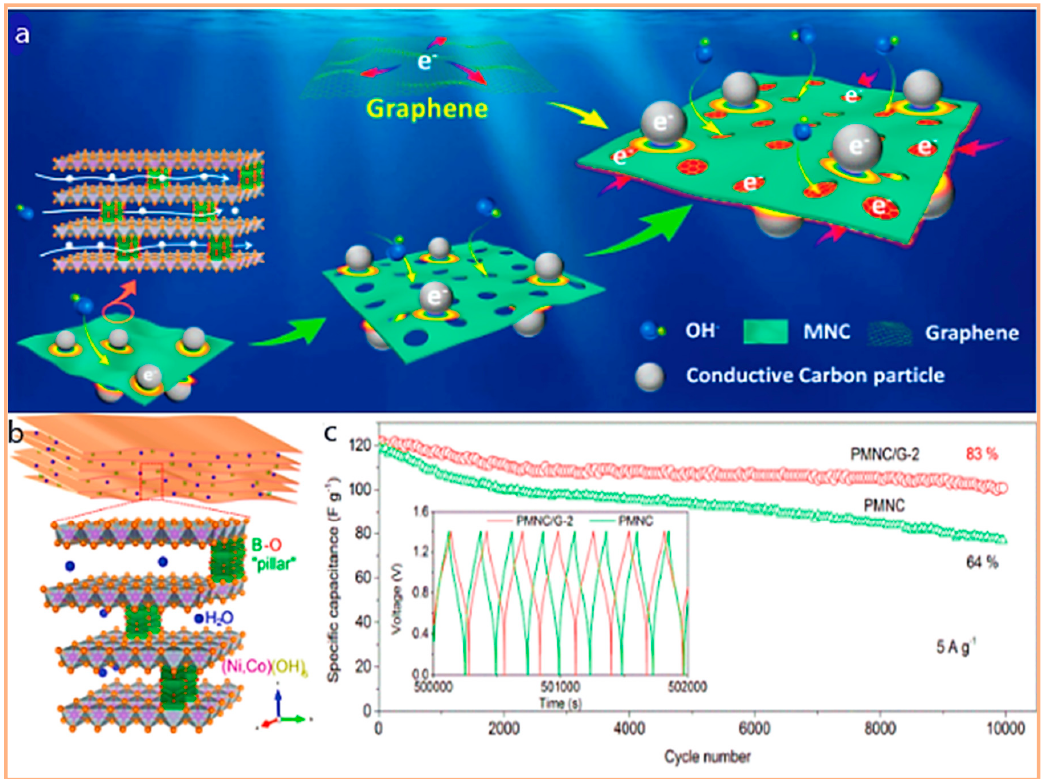
Figure 12. Graphical presentation of PMNC/G-2. ( a ) The layered structure of Ni 0.5 Co 0.5 (BO 2 ) y (OH) 2 − y xH 2 O. ( b , c ) Cycling performances of PMNC//AC and PMNC/G-2//AC ASSCs. Reprinted with permission from [197], Copyright 2017, American Chemical Society.